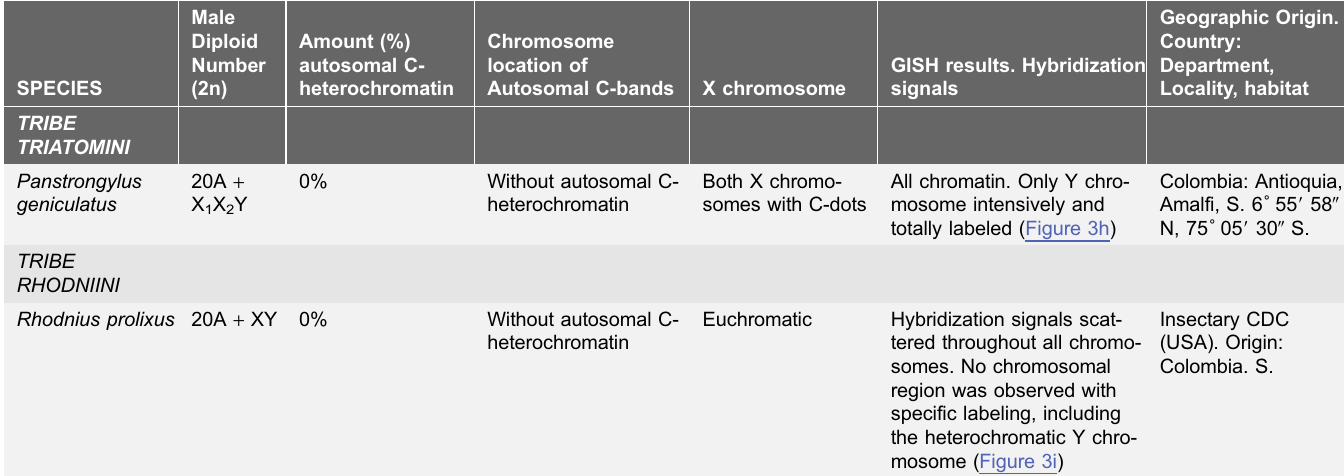
Triatoma genus, we studied the three main clades or groups: a) the Rubrofasciata Group (from Central and North America and Old World species): T. protracta and T. dimidiata , b) the Dispar Group (west of the Amazon region): Triatoma carrioni and c) the Infestans Group (from south and east of the Amazon region). For this group we included three closely related species of the infestans subcomplex ( T. delpontei , T. infestans and T. platensis ). In T. infestans we analyzed in the amount and chromosome distribution of the C-heterochromatin, both in autosomes and sex chromosomes (see Table 1).